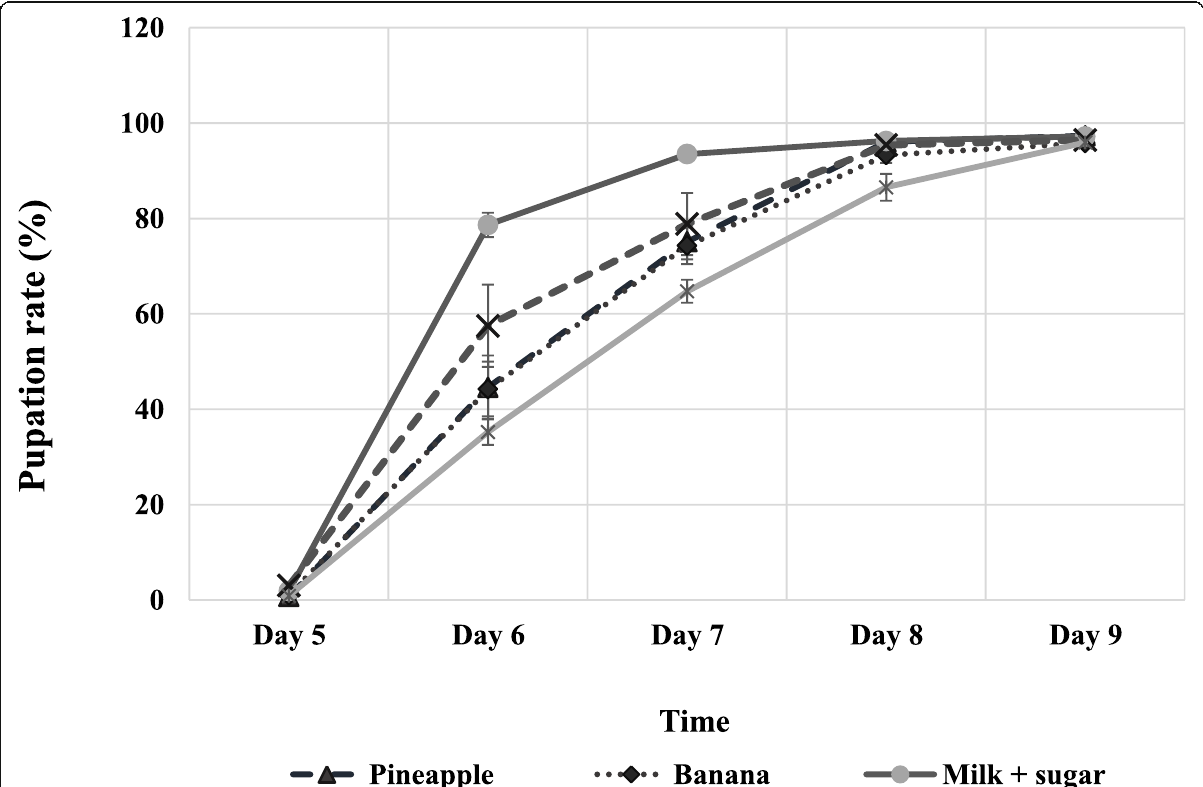
Fig. 3 Cumulative pupation rate of M. domestica larvae from different food-based rearing systems. Error bars represent standard